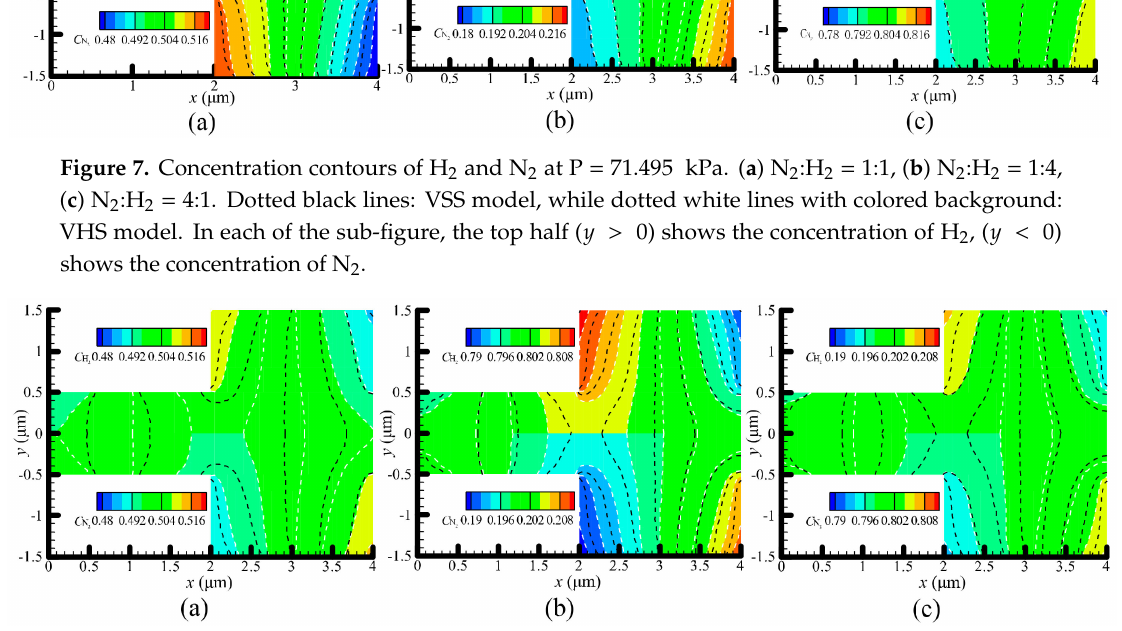
Figure 8. Concentration contours of H 2 and N 2 at P = 14.3 kPa. ( a ) N 2 :H 2 = 1:1, ( b ) N 2 :H 2 = 1:4, ( c ) N 2 :H 2 = 4:1. Dotted black lines: VSS model, while dotted white lines with colored background: VHS model. In each of the sub-figure, the top half ( y > 0) shows the concentration of H 2 , ( y < 0) shows the concentration of N 2